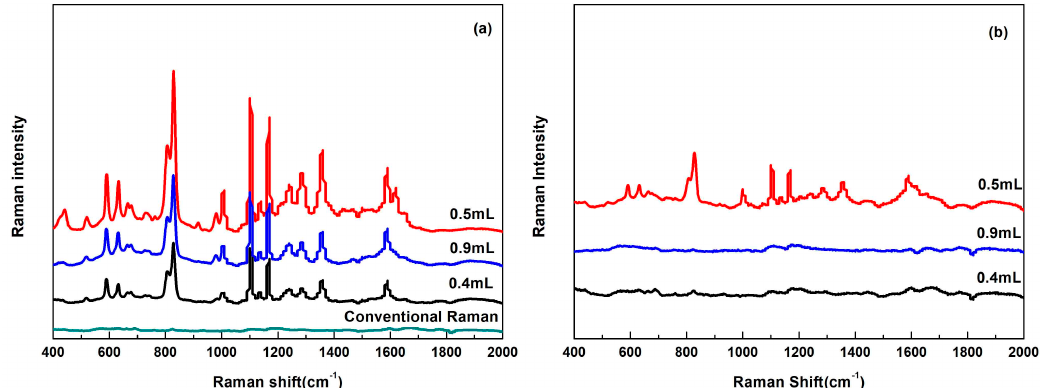
Figure 4. Conventional Raman spectra and surface-enhanced Raman scattering spectra of ( a ) 1 mg/L and ( b ) 0.1 mg/L flusilazole standard solutions using Au@Ag with various amounts of Au seeds including 0.4, 0.5, 0.9 mL.